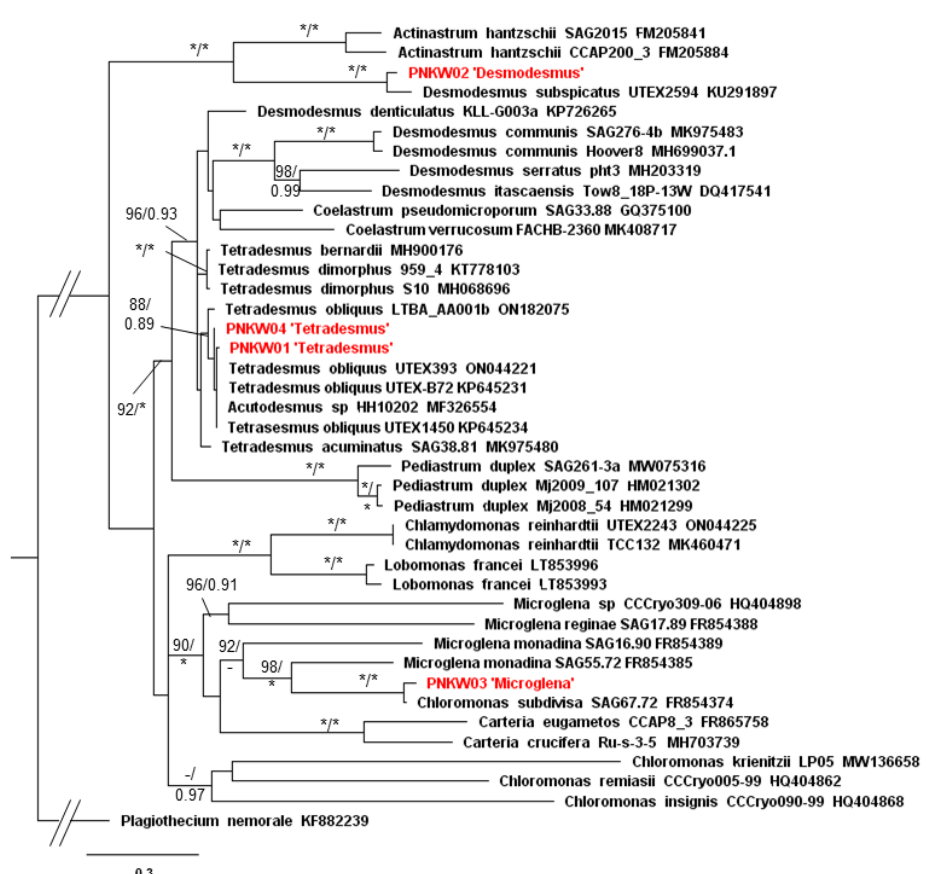
Figure 2. Phylogenetic tree of microalgae with Plagiothecium (bryophyte) as the outgroup taxa based on the nuclear ITS markers (1363 bp total). The tree shows the position of the studied strains among the green microalgae. Numbers on the branches indicate bootstrap values from ML followed by posterior probabilities from the BI analysis. Asterisk (*) indicates 100 (ML) and 1.00 (BI) values, while negative values (−) indicate values below 90 (ML) and 0.90 (BI). Names of taxa were verified according to the recent taxonomic changes with the use of the AlgaeBase database [17]. The topology of the tree was based on the ML